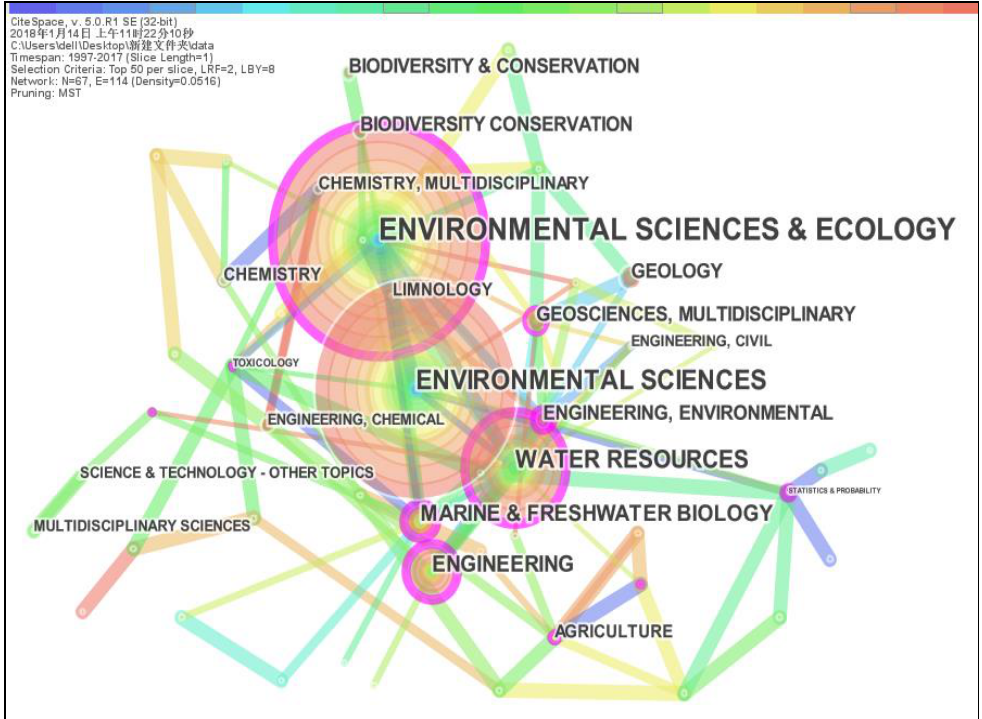
Figure 4. Top ten directions for WQI research from 1997 to